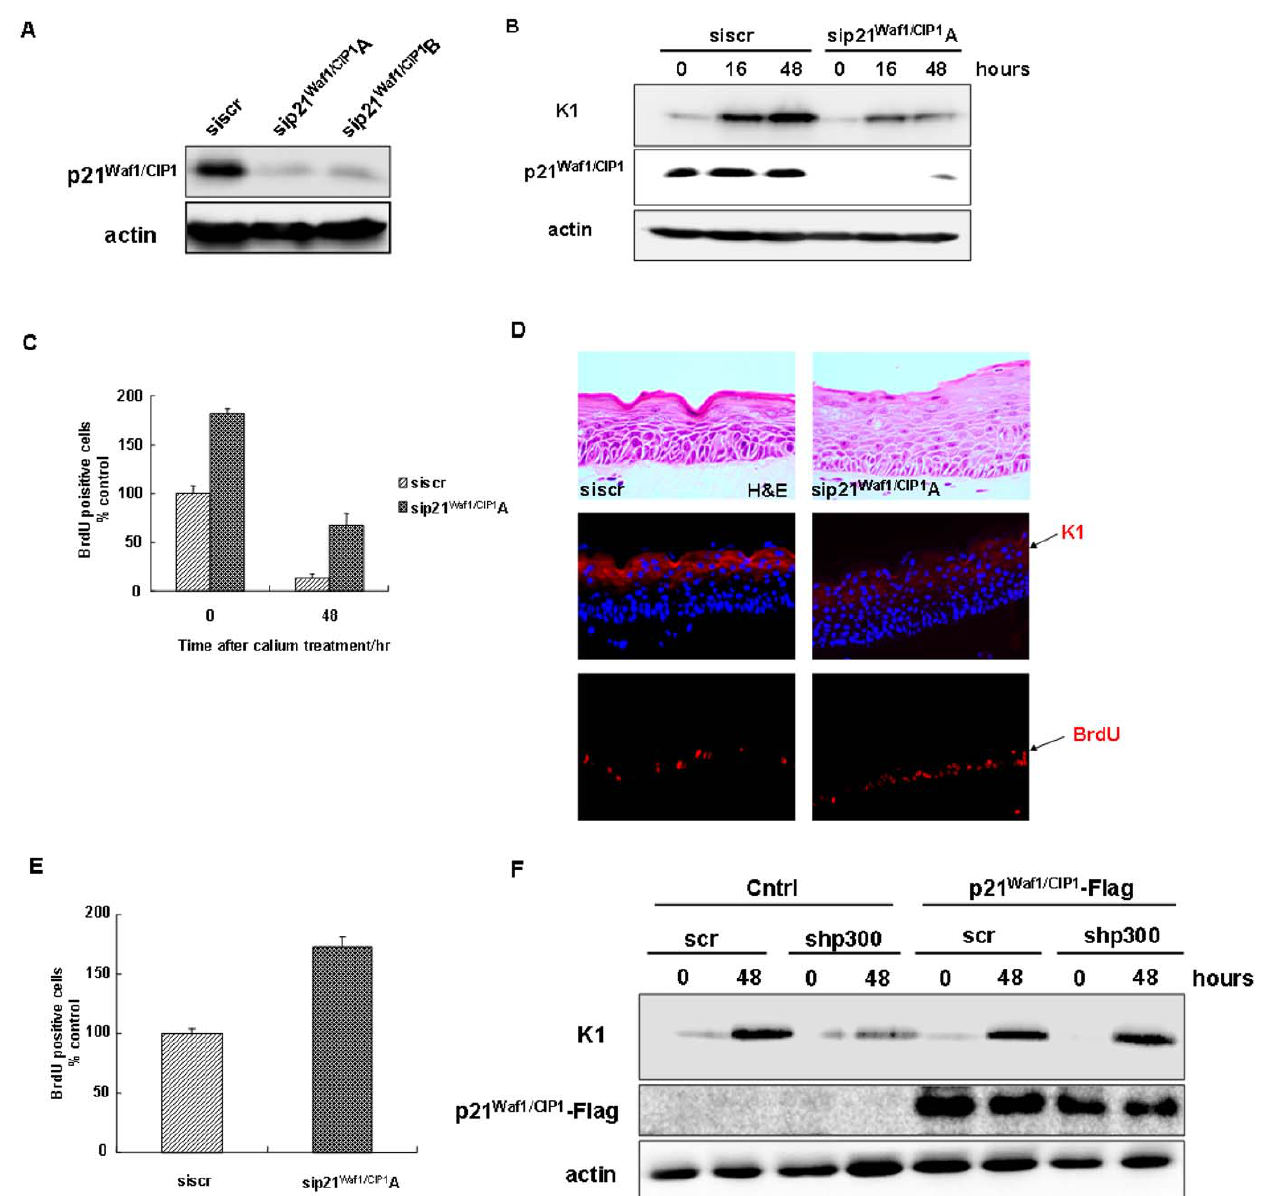
Figure 5. p21 Waf1/CIP1 knockdown inhibits early keratinocyte differentiation of organotypic keratinocyte raft cultures. HFKs were transiently tranfected with p21 Waf1/Cip1 targeting siRNA molecules. ( A ) Immunoblotting of the whole cell lysates with p21 Waf’1/CIP1 antibody shows that both siRNAmolecules, sip21 Waf’1/CIP1 A andsip21 Waf’1/CIP1 B, were able to knockdownp21 Waf’1/CIP1 protein levels efficiently ( , 90%) ( B ) Western blot shows p21 Waf1/CIP1 depletion with sip21 Waf1/CIP1 A and a decreased in K1 levels after 48 hours of differentiation. ( C ) Transfected cells were seeded onto coverslips, incubated with 1.5 mM calcium for 48 hours, and were pulsedwith BrdU prior to fixation. BrdU uptake indicates a 90% increased proliferation of p21 Waf1/CIP1 knockdown cells prior to theaddition differentiation (t=0). After 48 hours calcium treatment, around 40%of thep21 Waf1/CIP1 knock-down cells remained BrdU positive. ( D ) H&E staining shows an increase in thickness of epithelia in p21 Waf1/CIP1 depleted cells (upper panel). Immunohistochemisty staining of organotypic raft cultures indicates that the differentiation marker K1 is reduced in p21 Waf1/CIP1 knockdown rafts with low levels of K1 (middle panel). Rafts were pulsed with BrdU for 16 hours prior to harvest and BrdU positive cells counted (lower panel). BrdU positive cells were observed in most parabasal cells. ( E ) Graph represents BrdU uptake expressed as percentage of scrambled control (Mean + / 2 SE, two independent experiments). (F) Stably expressing p300 targeted shRNA cells were transiently transfected with either 1 m g pMT5-p21 Waf1/CIP1 -Flag vector or pCMV empty vector (negative control) for 24 hours. Transfected cells were then incubated with calcium for 48 hours. Western blot analysis indicates that exogenous expression of p21 Waf1/CIP1 rescued the expression of K1 in p300 depleted cells. doi:10.1371/journal.pone.0008369.g005 p21 Waf1/CIP1 can rescue the proliferation and differentiation defect (Figure 5D & E). Interestingly, BrdU positive cells were also observed in the suprabasal layer of p21 WAF1/CIP1 depleted raft, of p300 depleted cells, we transiently transfected the scramble indicating that these cells did not exit cell cycle properly as they and shp300 cell lines with either the vector containing human migrate upwards. To determine whether exogenous expression of p21 Waf1/CIP1 cDNA with a N-terminal Flag tag or pCMV empty